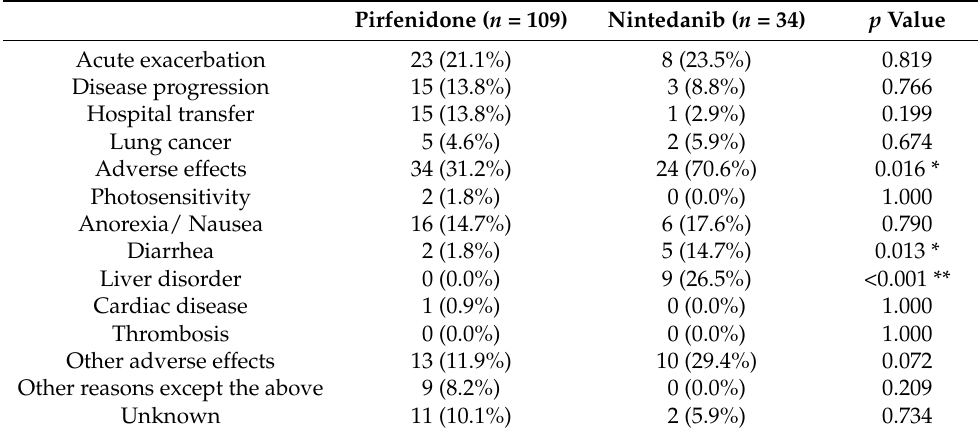
Table 2. Discontinuation reasons during the whole